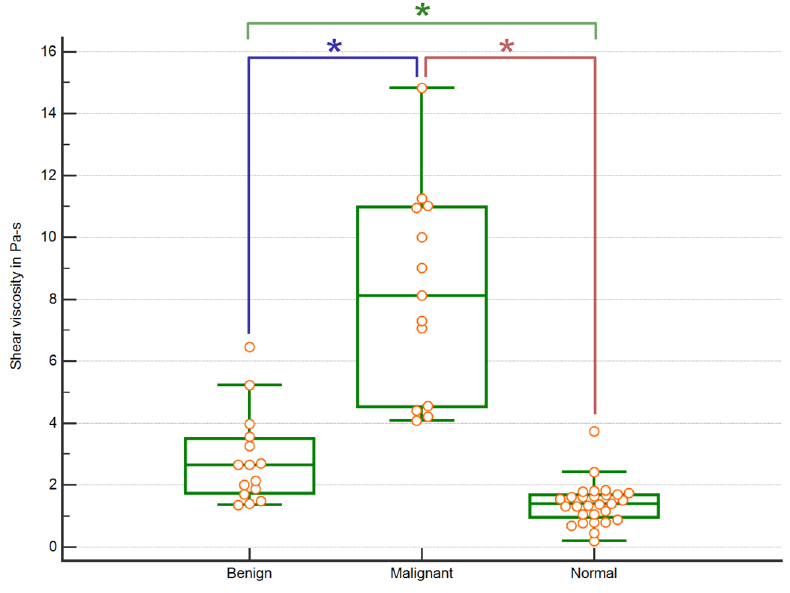
Fig 5. Box plot showing shear viscosity distribution for benign masses, malignant masses and normal tissue estimated using a Voigt model with significantly different pathologies marked.